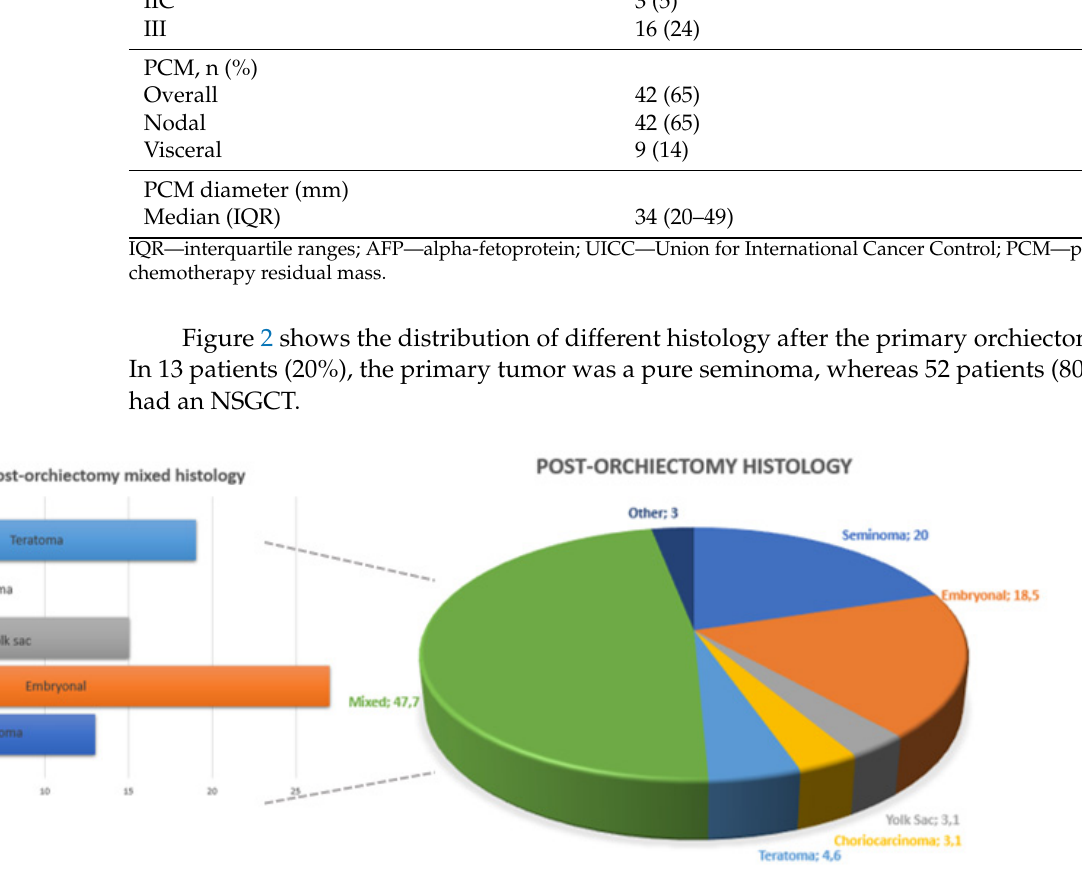
Figure 2. Overall and mixed distribution of testicular cancer histotypes at post-orchiectomy pathology.